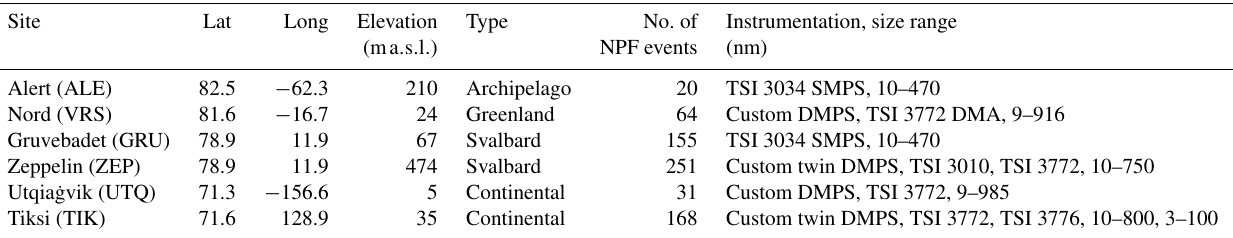
Table 1. List of sampling sites and NPF events (689 in total). We separate the sites into types based upon the classification given by Schmale et al. (2021). Two ranges for the size range are given for Tiksi, as the second condensation particle counter (CPC) was changed from the TSI 3772 model to the TSI 3776 model. SMPS is a scanning mobility particle sizer, DMPS is a differential mobility particle sizer, and DMA is a differential mobility